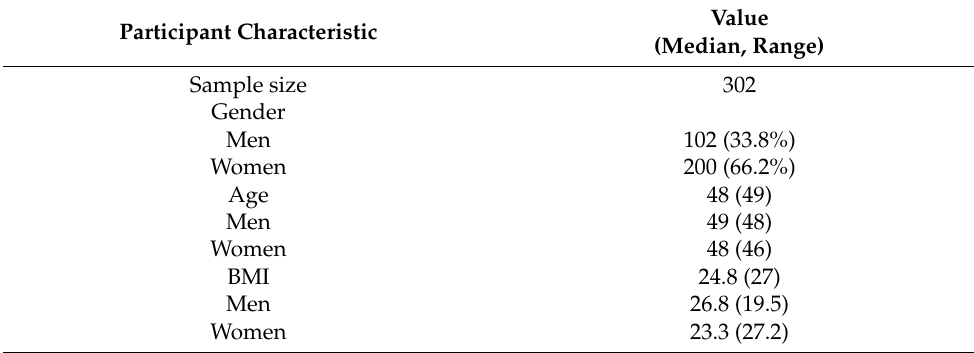
Table 1. Characteristics of the study